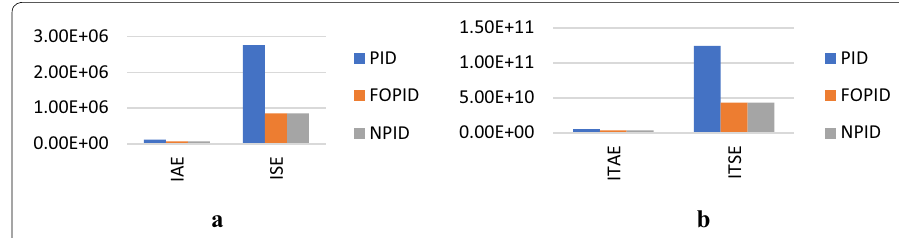
Fig. 15 a Comparison between (IAE) and (ISE), b comparison between (ITAE) and (ITSE)